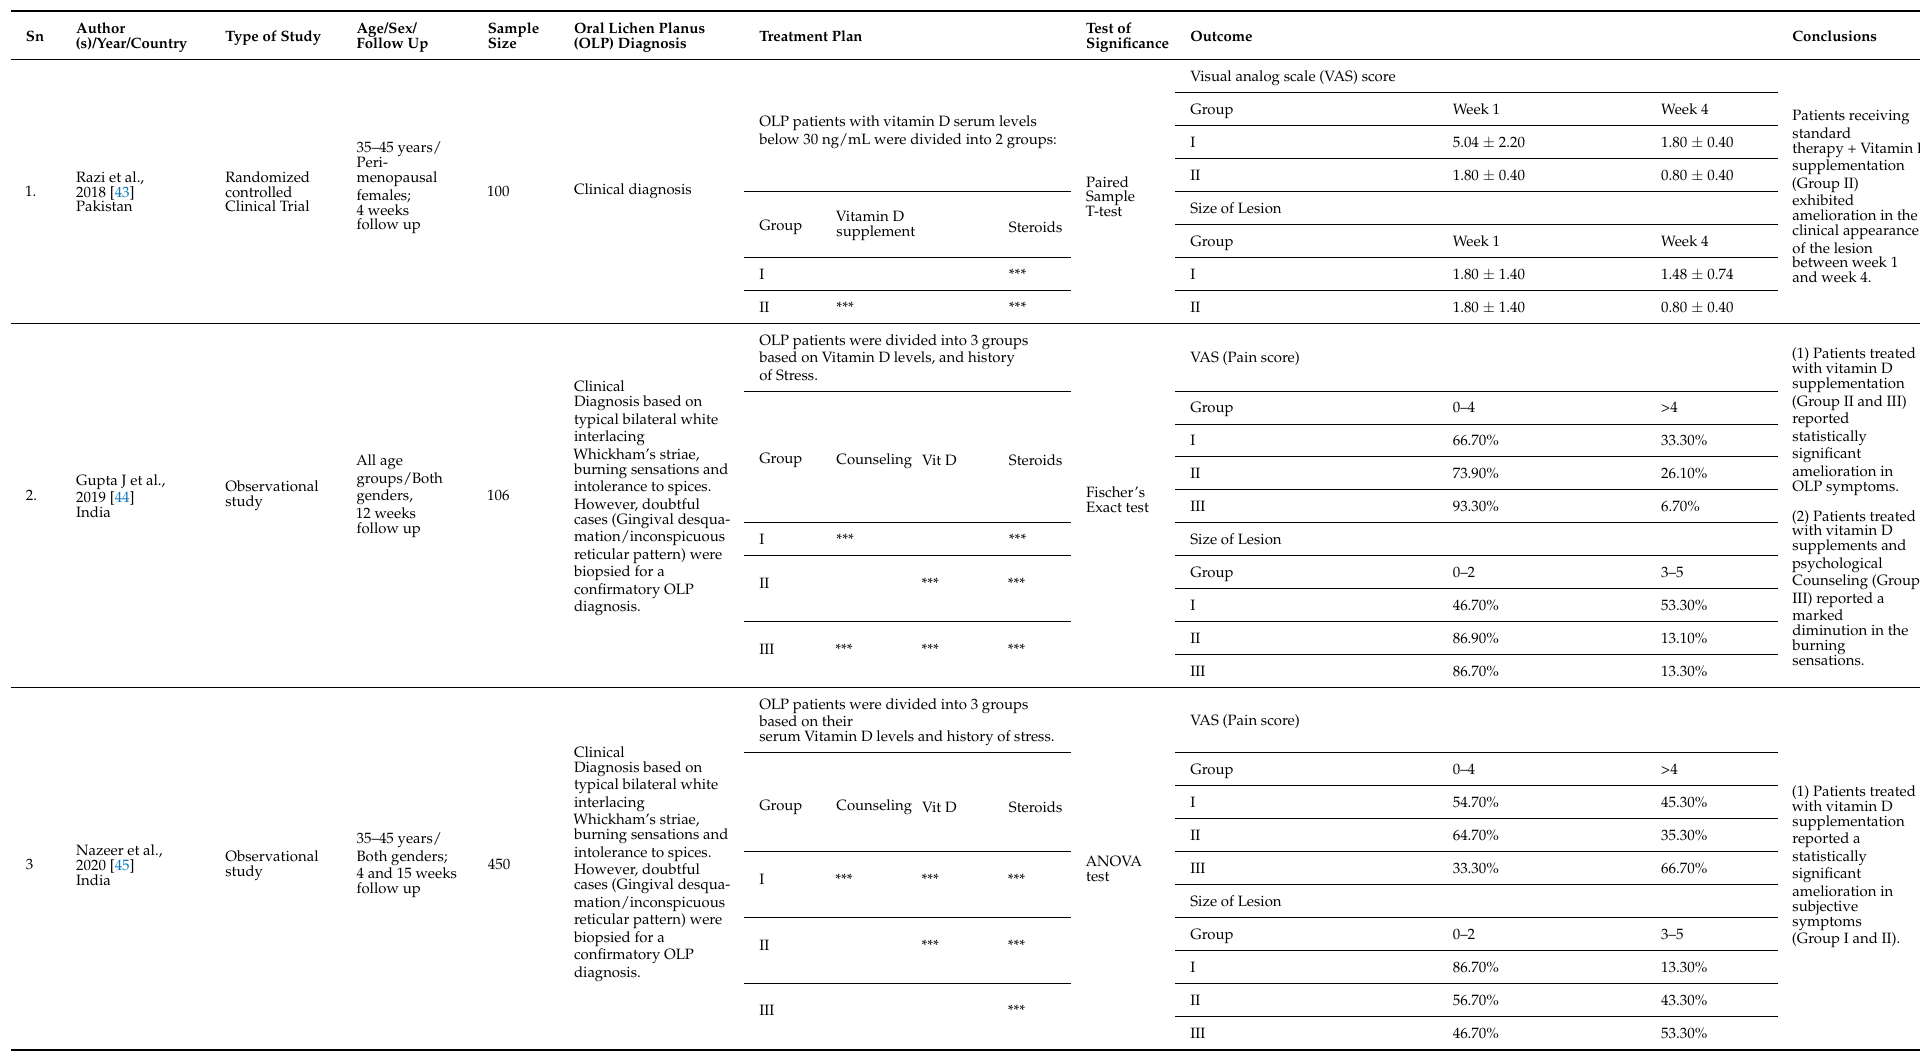
Table 1. Detailed representation of the included